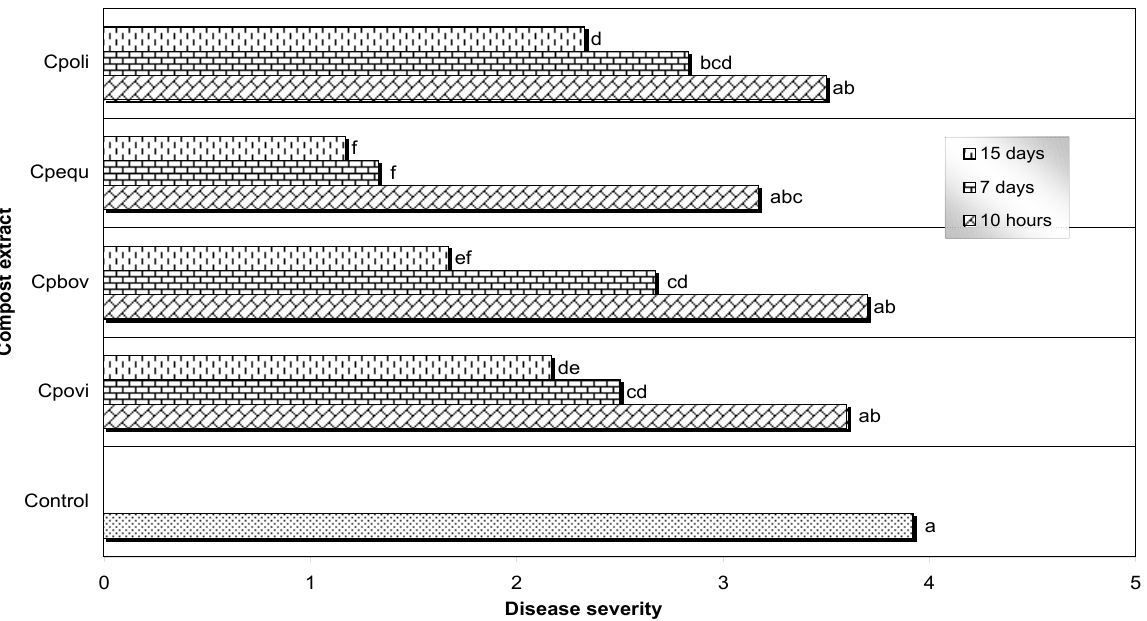
Fig. 1. Effect of fermentation time on compost extract effectiveness against Botrytis cinerea on tomato plants. Controls were sprayed with tap water before inoculation with B. cinerea . Grey mould severity was evaluated ac- cording to a 5 point index where 0, healthy and 5, completely rotted leaves. Treatments with different letters differed significantly ( P =0.05) according to the Newman Keuls